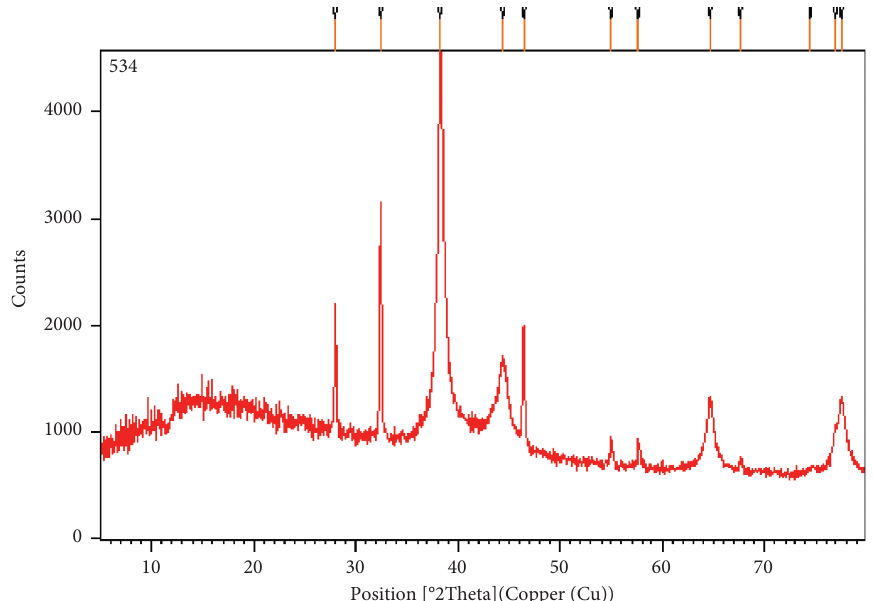
Figure 3: XDR pattern of Ag-doxycycline nanoparticles.